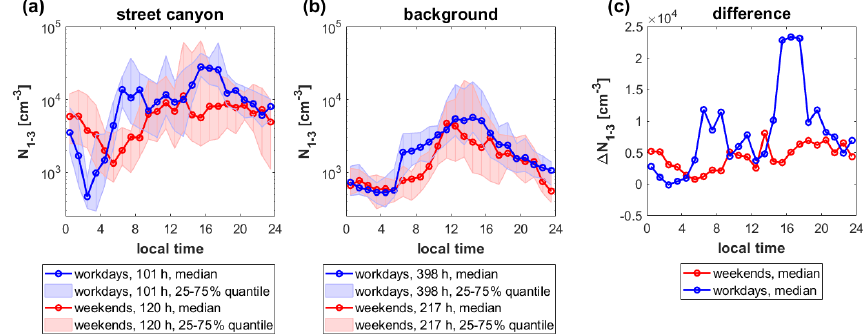
Figure 3. The diurnal variation of sub-3nm particle concentration during weekends (red) and workdays (blue) (a) at the street canyon and (b) at the background station; (c) the difference between median sub-3nm particle concentration at the street canyon (a) and at the background station (b) . The median diurnal variation is shown as a solid line with markers; the 25th and 75th percentile ranges are presented as shaded